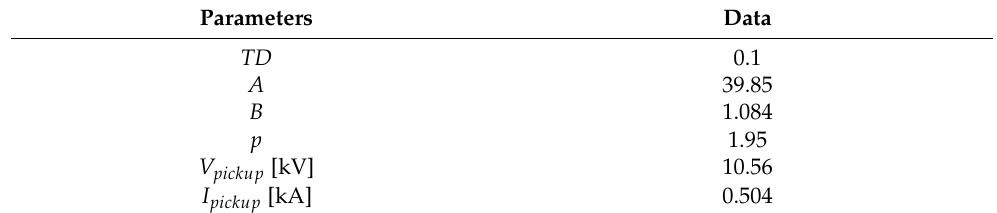
Table 3. Parameters of